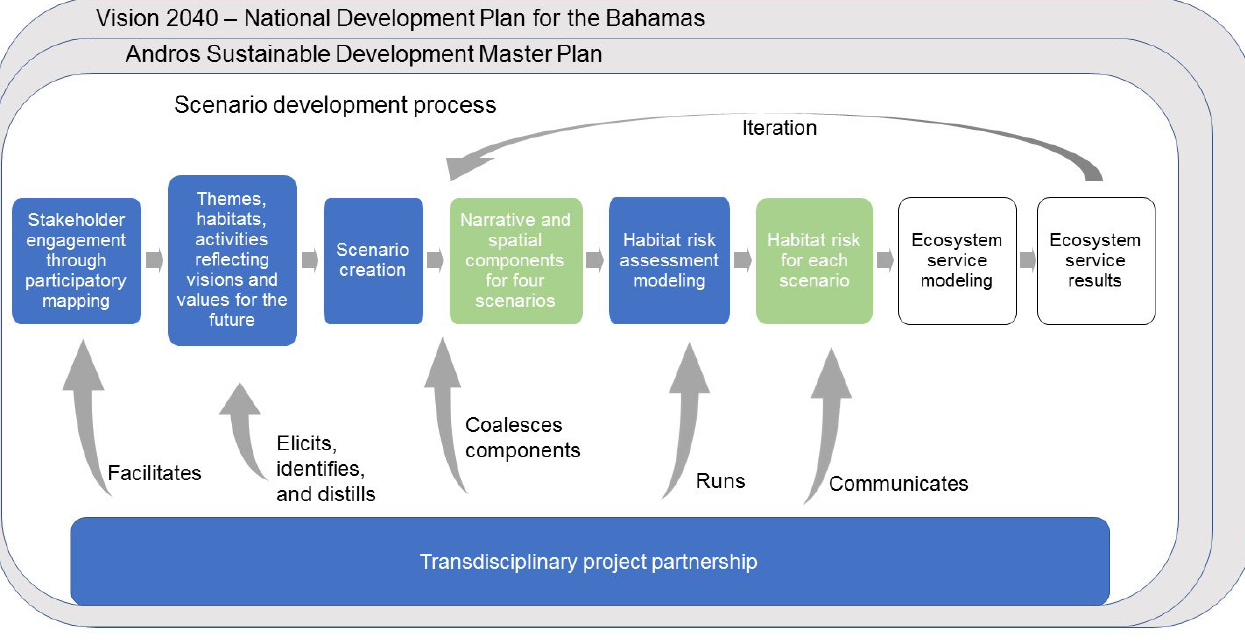
Fig. 1 . Conceptual diagram for scenario development process. Blue boxes represent steps in the process. Green boxes represent outcomes from those steps. White boxes were critical to the overall project but are not reported upon in this paper. The scenario development process was nested within the Andros Sustainable Development Master Plan and Vision 2040, the National Development Plan for the